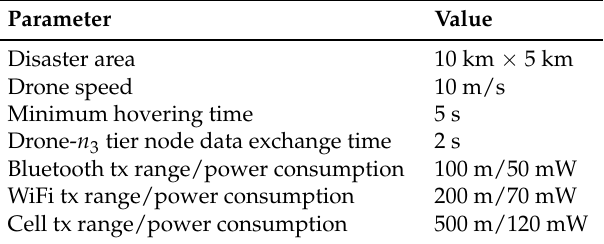
Table 3. Summary of used parameters.